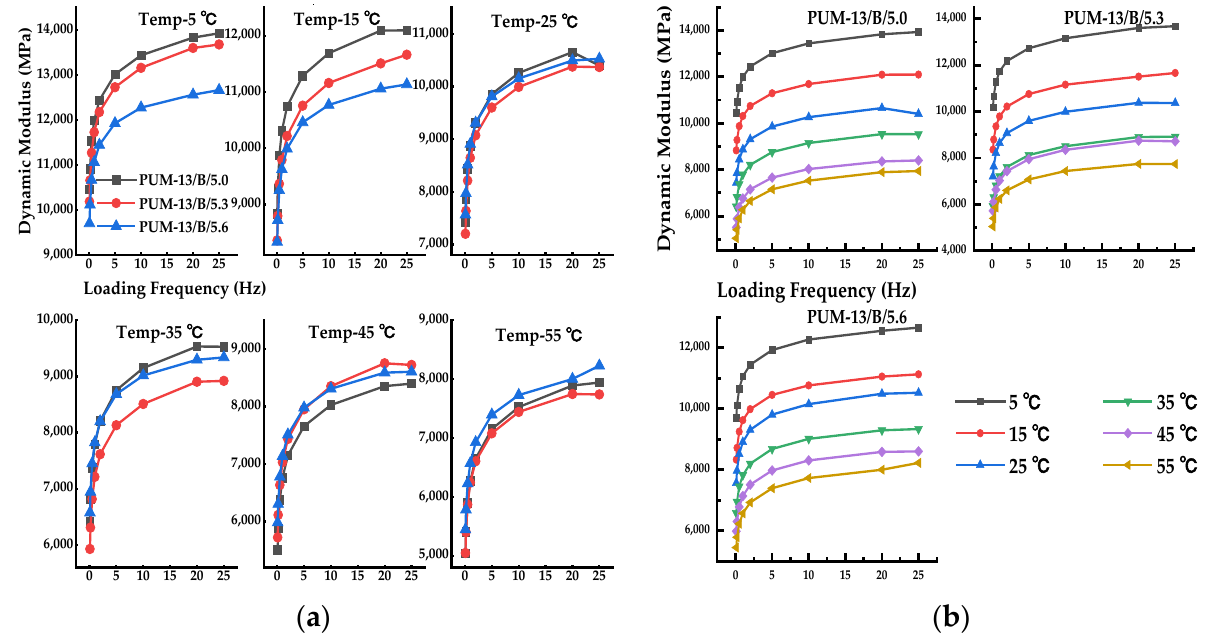
Figure 11. The phase angle of the PU mixtures with the same gradation and different PU contents. ( a ) phase angle under different test temperatures, ( b ) phase angle with different PU contents.